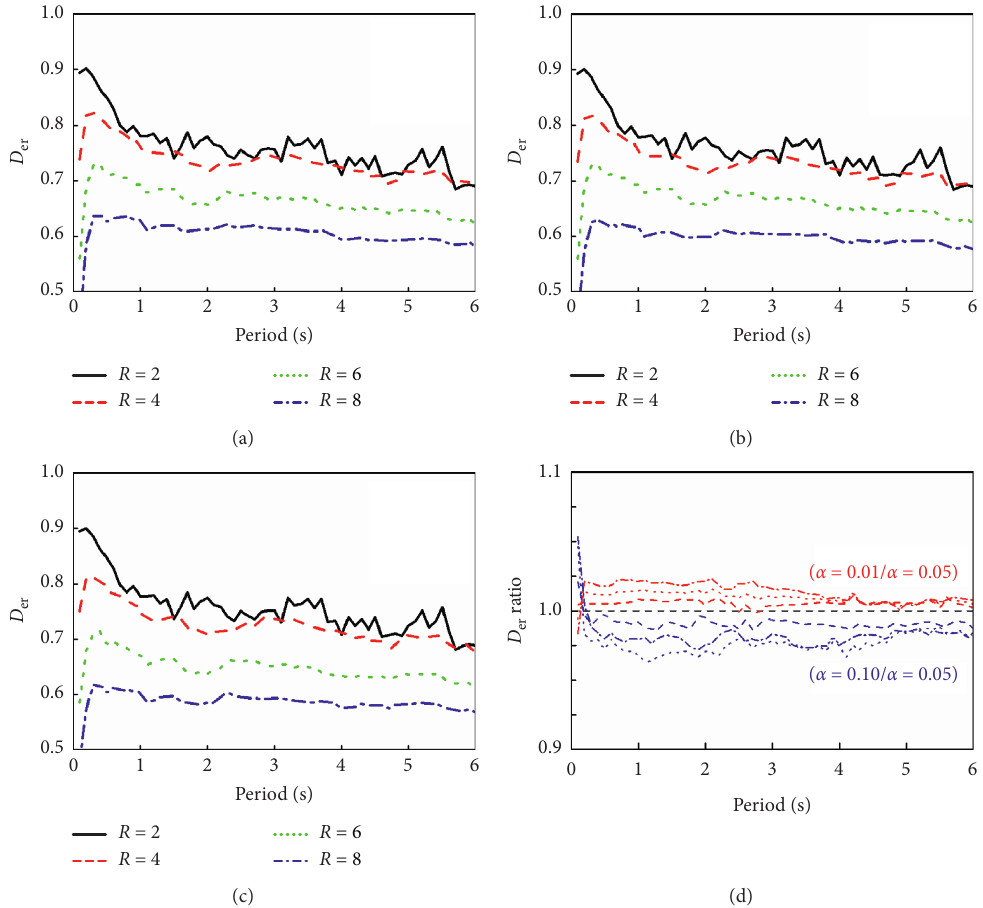
Figure 4: Duration spectrum for different postyield stiffness ratios. (a) α � 0.01. (b) α � 0.05. (c) α � 0.10. (d)